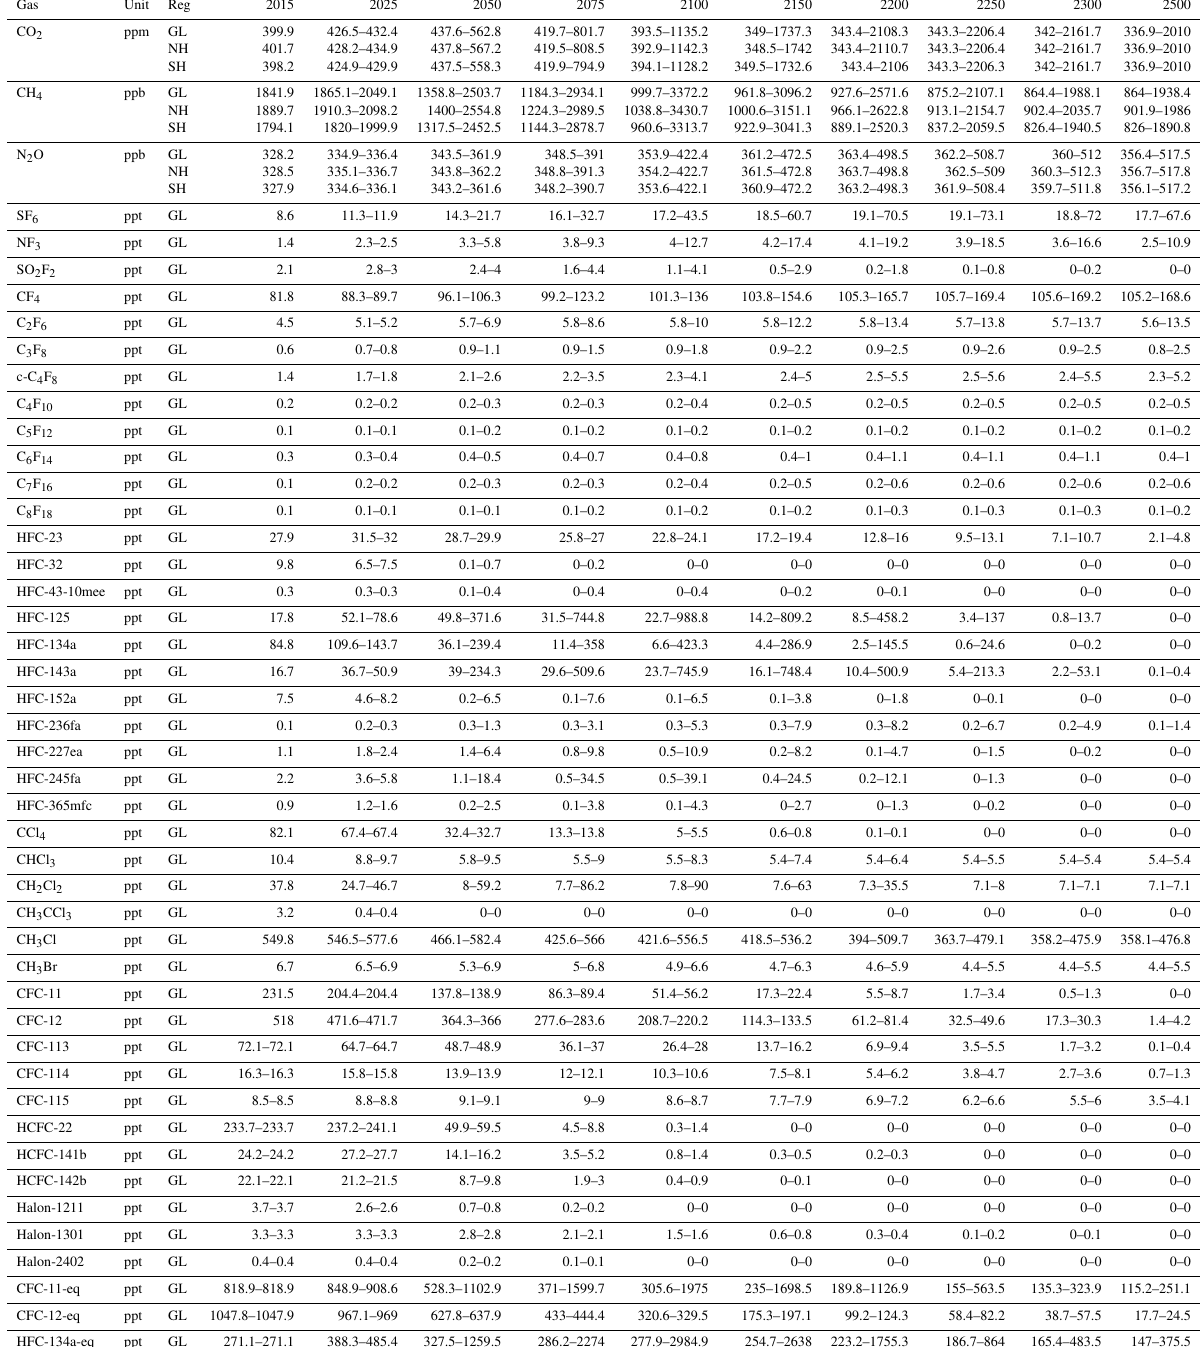
Table 4. Overview of future scenario range of individual GHG concentrations. The table indicates the minimum and maximum surface air mole fractions across the nine SSP scenarios considered in this study. For spreadsheets with annual data tables per scenario, see http: //greenhousegases.science.unimelb.edu.au. The third column indicates the region, with global (“GL”), northern hemispheric (“NL”) and southern hemispheric (“SH”) data shown for CO 2 , CH 4 and N 2 O. The last three rows provide the equivalence concentrations. The